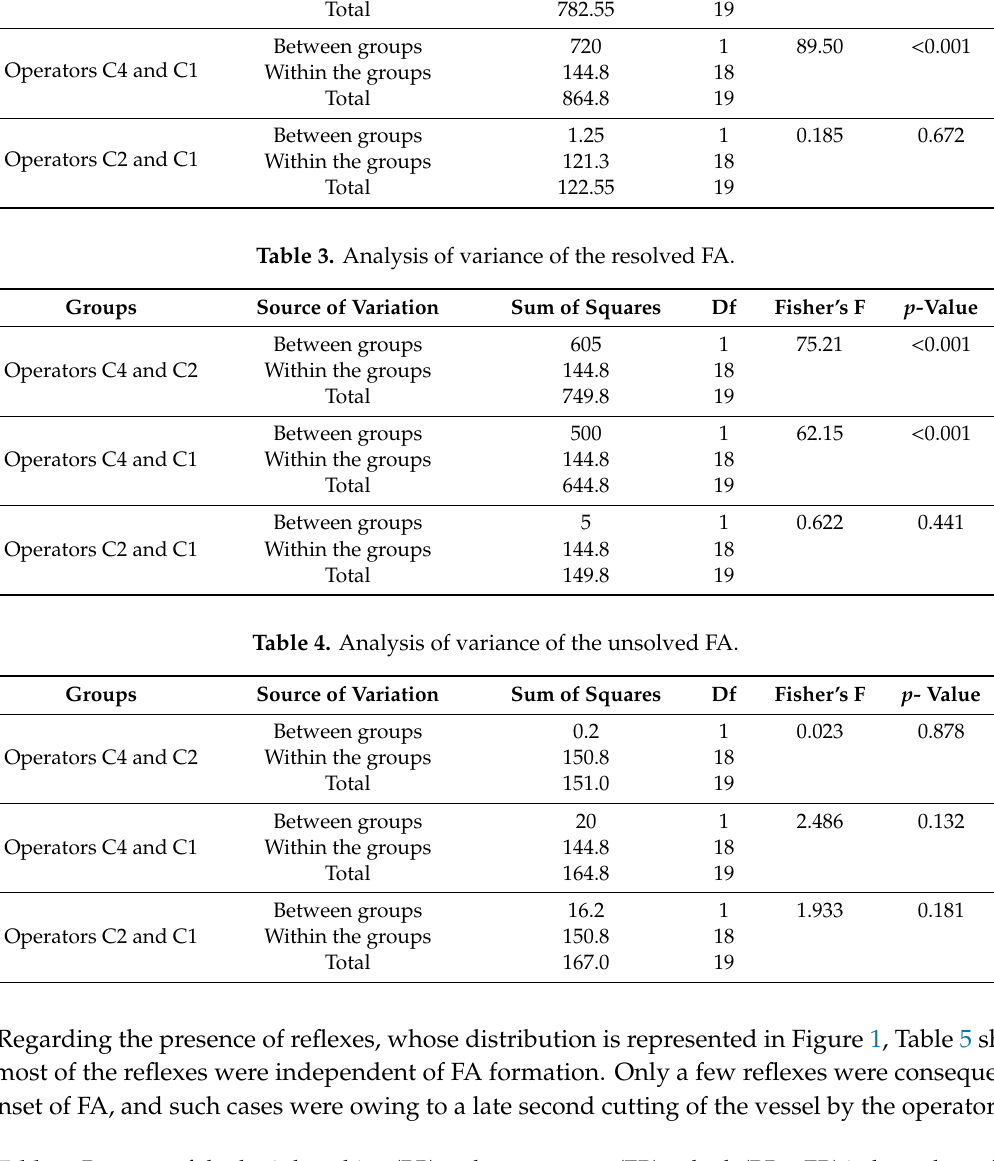
Table 5. Presence of rhythmic breathing (RB) and eye response (ER) or both (RB + ER) independent of and / or consequential to the formation of a false aneurysm